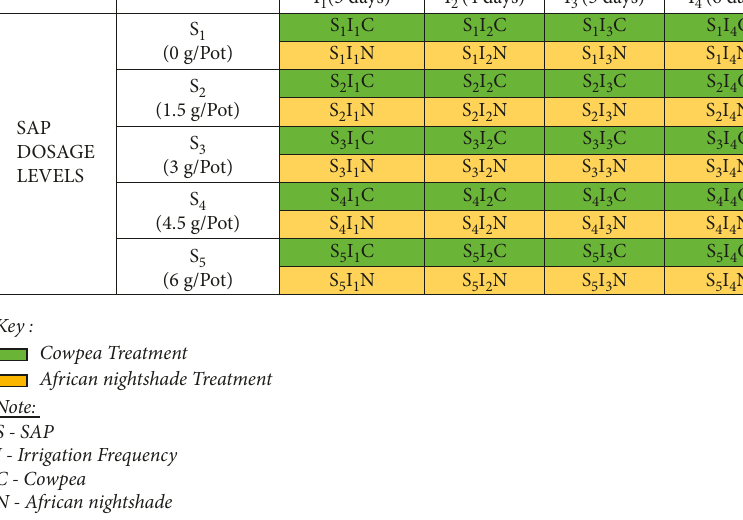
Table 1: Field layout of the experimental design. IRRIGATION